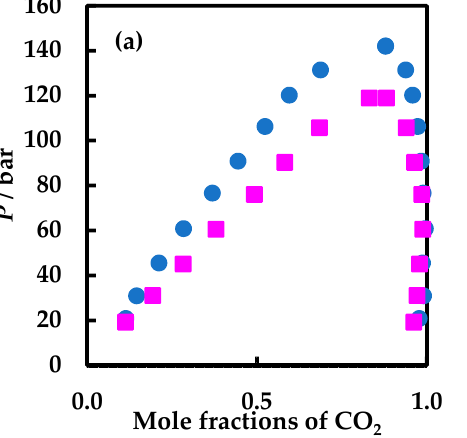
Figure 3. Pressure–compositions data for the carbon dioxide + isobutanol and + tert -butanol systems at 363.15 K ( a ) and 373.15 K ( b ): ( ● , ● ), CO 2 + isobutanol; ( ▪ , ▪ ), CO 2 + tert -butanol.